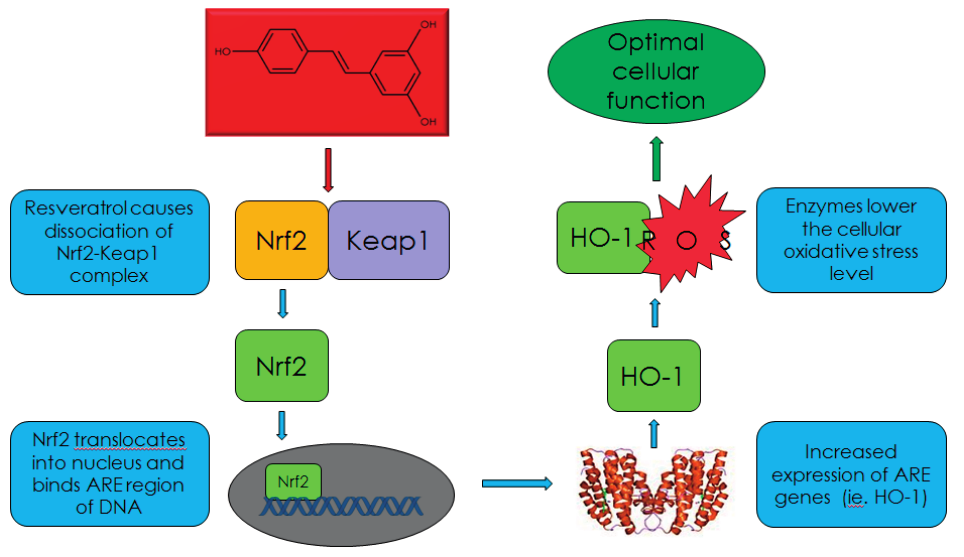
Figure 1. Schematic representation of Resveratrol activating the Nrf2 pathway